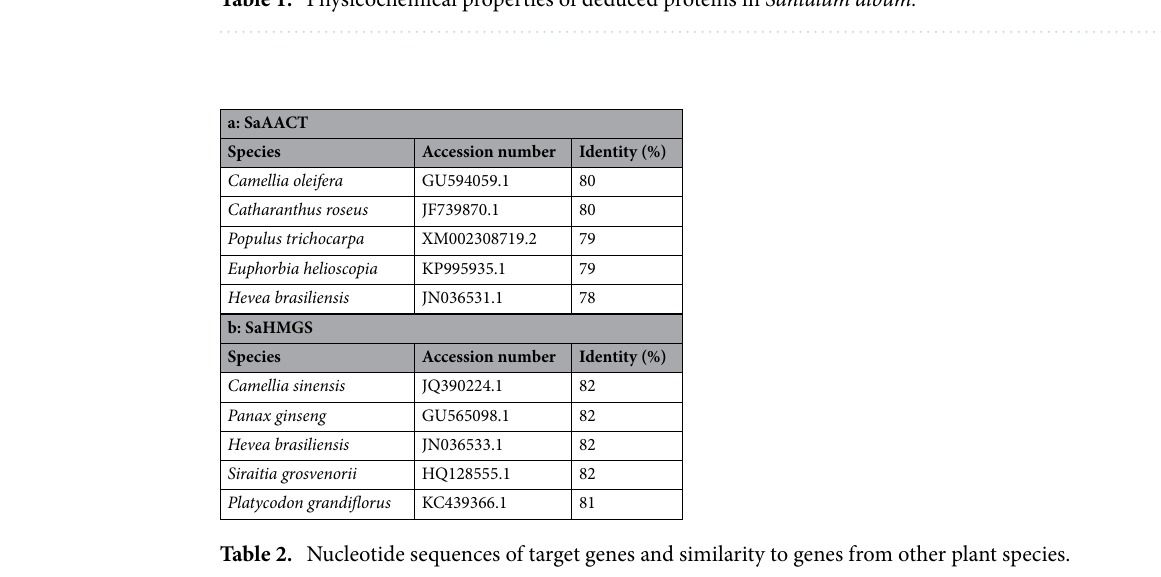
Table 1. Physicochemical properties of deduced proteins in Santalum album.